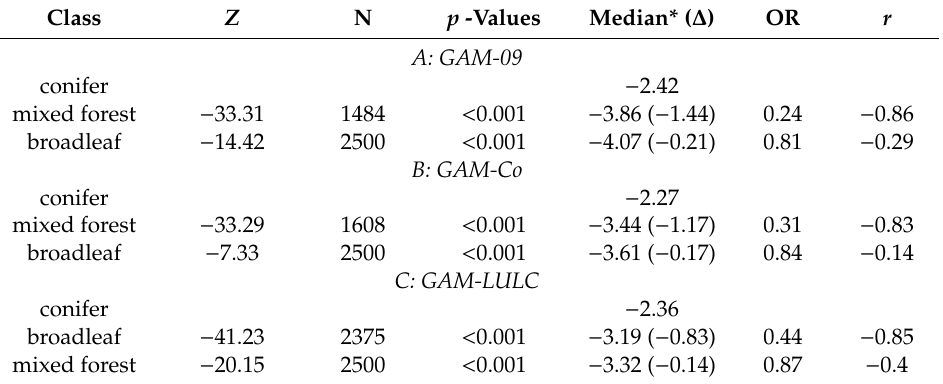
Table A8. Wilcoxon signed rank test for OR of LULC variable forest